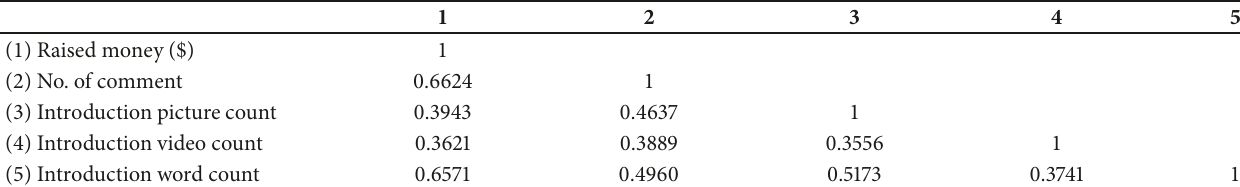
Table 3: Correlations of variables.